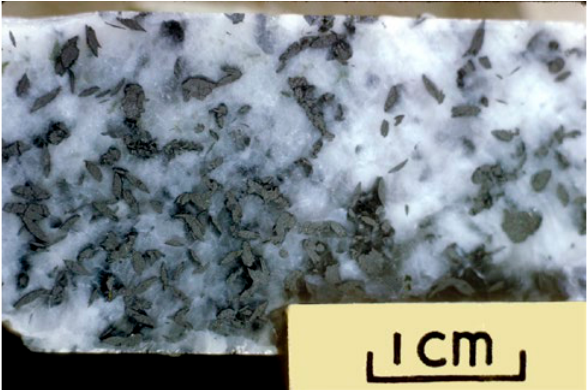
Figure 84. Colloform vein quartz from Mt. Gee, Flinders Ranges, South Australia, contains delicate acicular dawsonite needles. A precursor gel stage of the quartz is indicated by the enhanced growth of these needle-like crystals. They were supported in a yielding medium through which material for crystal growth could diffuse. Subsequent quartz crystallisation nucleates at, and radiates from, the pre-existing dawsonite